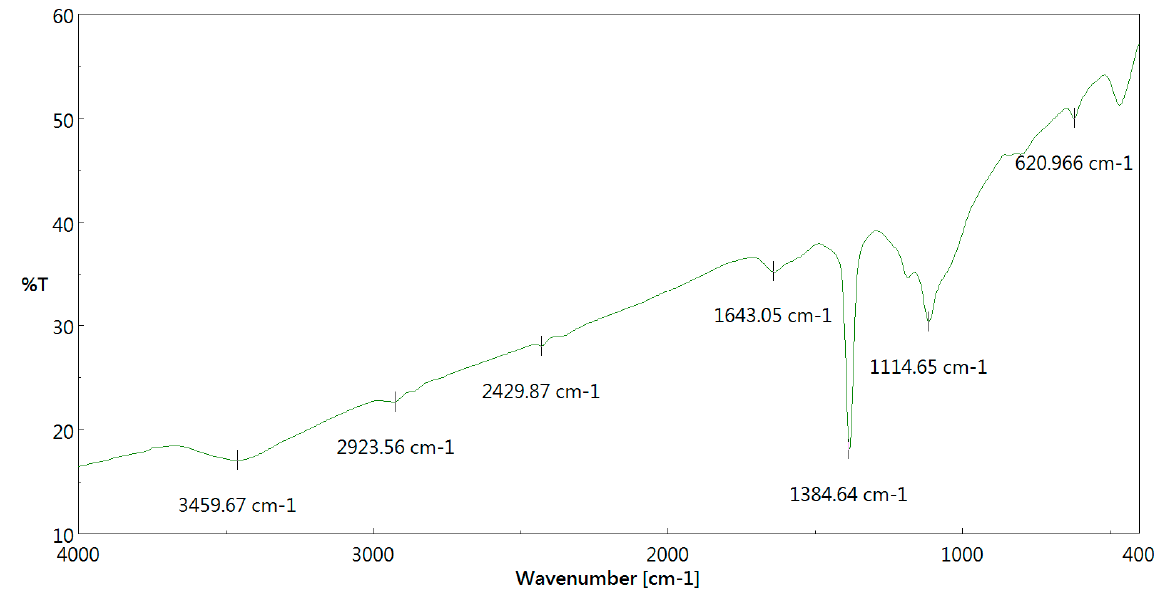
Figure 7. FTIR spectrum of the resulting biochar (BRH-900-30).